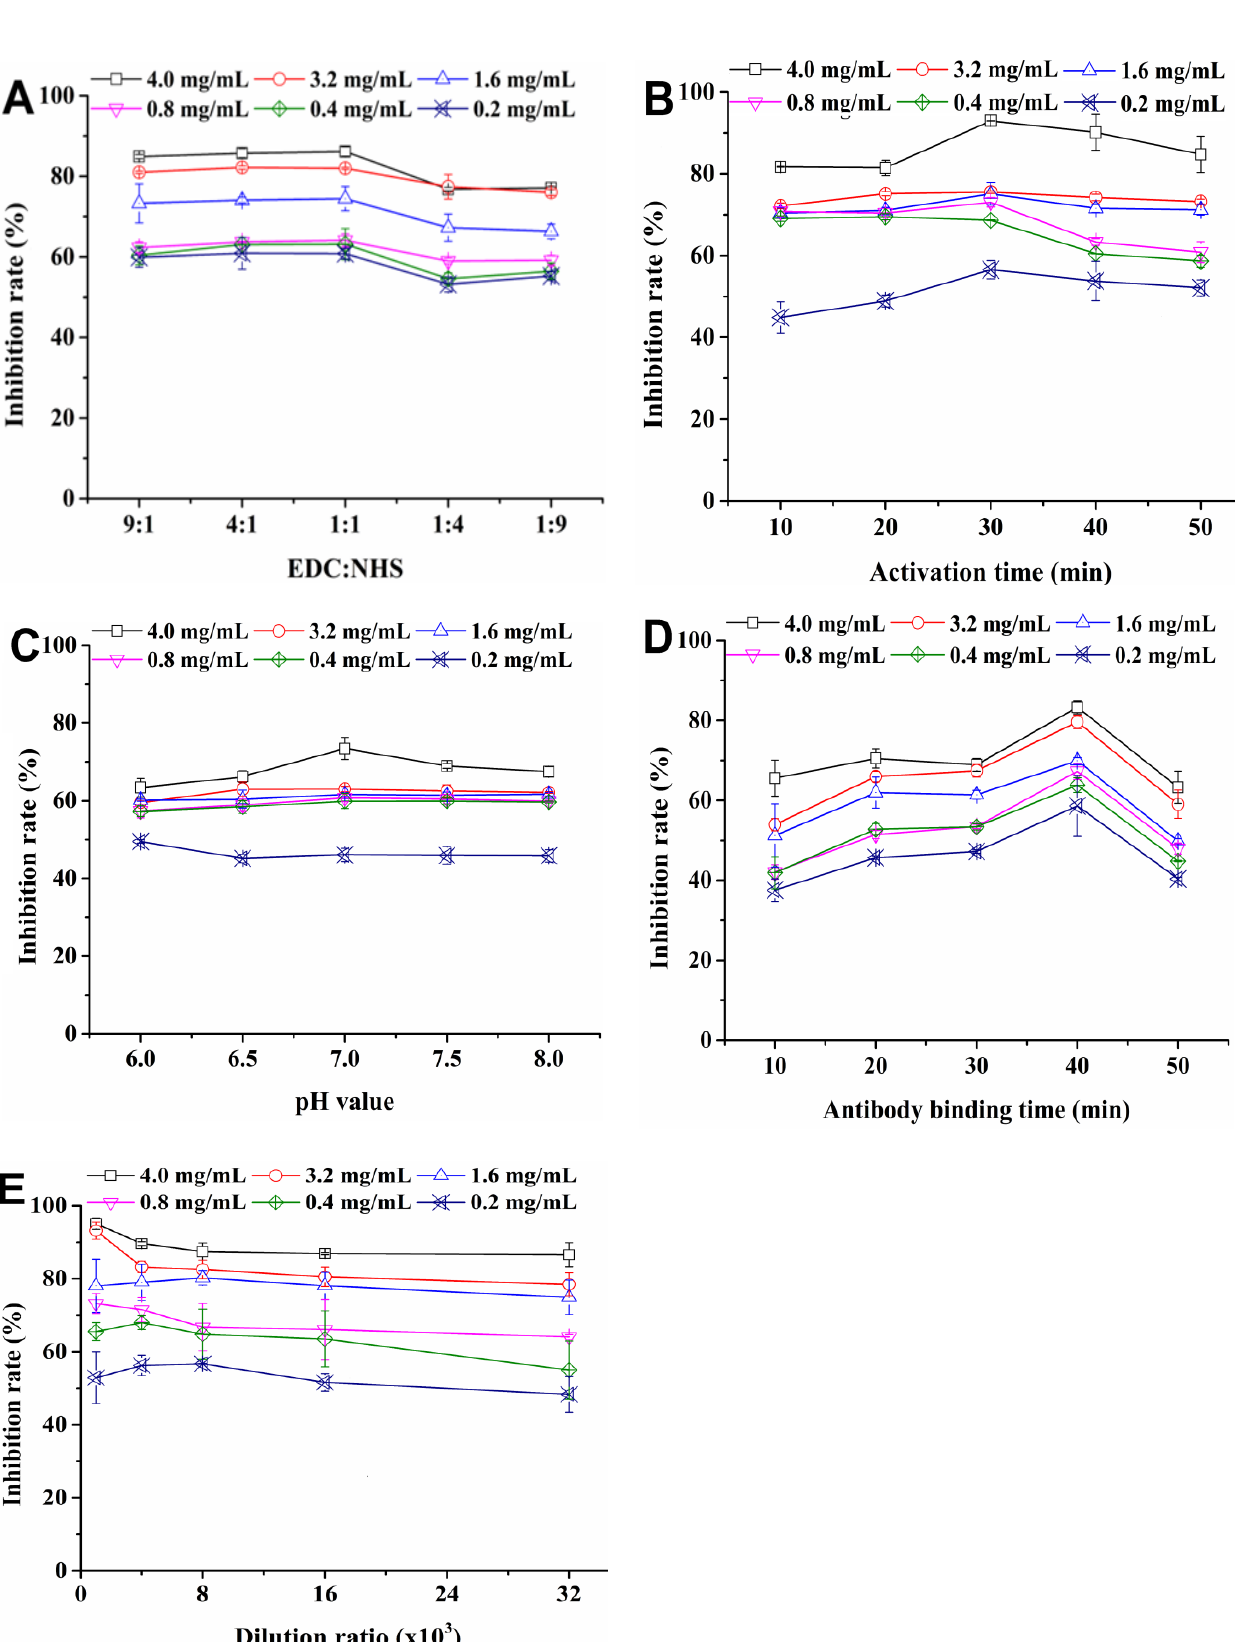
Figure 3. Investigation of the effects of the antibody and PLGA-NP coupling process on antibacterial performance. The effects of the ratio of EDC to NHS ( A ), activation time ( B ), pH value ( C ), binding time ( D ), and antibody usage ( E ) on the inhibition rate were investigated. Error bars represent the standard error of at least three independent